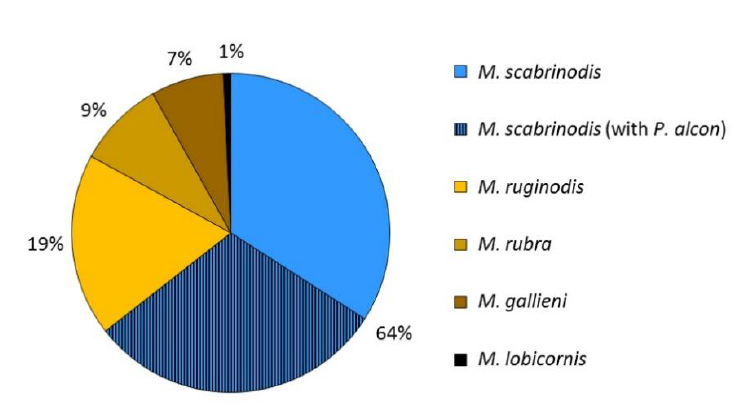
Figure 5. Myrmica ant species composition at the site of Phengaris alcon in the Białowieża Forest and proportion of Myrmica scabrinodis nests infested by the butterfly.